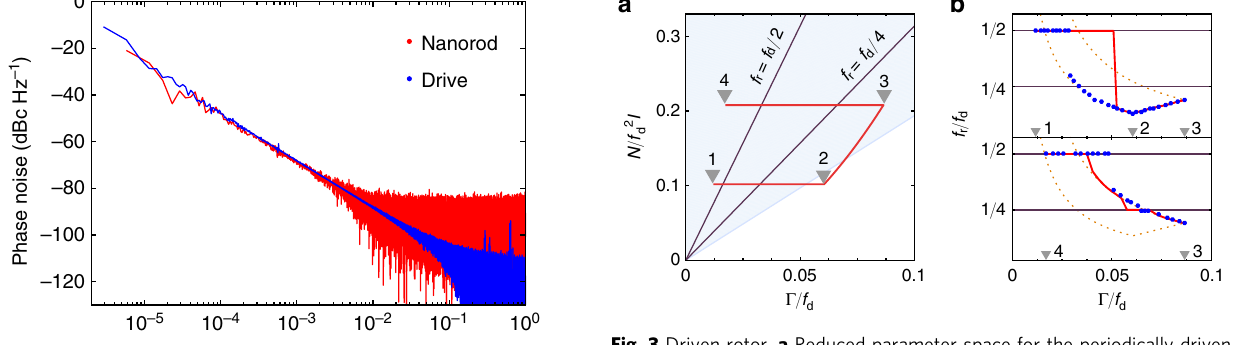
Fig. 3 Driven rotor. a Reduced parameter space for the periodically driven nanorod. Different regions can exhibit different limit cycles, as determined by the initial conditions. Within the blue shaded region f r : f d = 1:2 – locking can occur, while it can not be realized in the white region. Along the labeled solid lines the frequency of threshold rotation coincides with 1:2 – or 1:4 – locking. To explore the various limit cycles we select a path in parameter space (solid red line) which we follow experimentally by adiabatically varying p g and f d . b Experimentally measured rotation frequencies f r along the path in parameter space (blue points), and simulation (solid red line). The three different limit cycles observed are: threshold rotation (orange dotted lines), 1:2 – and 1:4 – locking (horizontal solid lines)